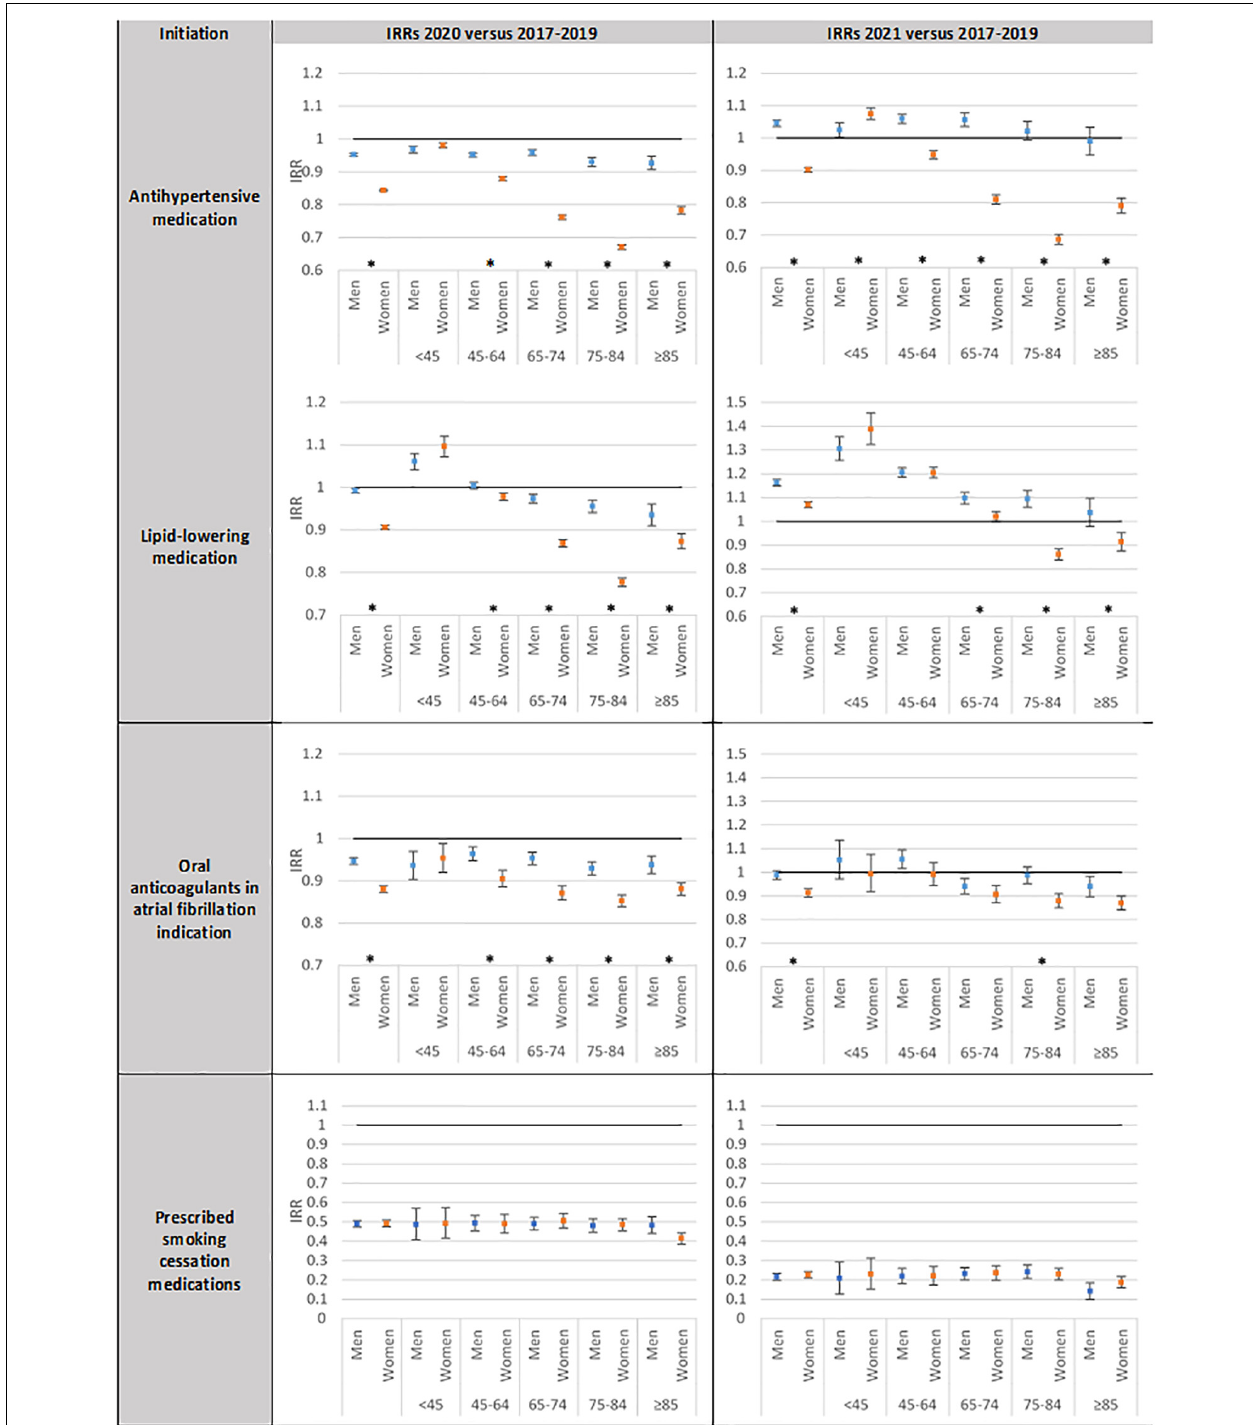
FIGURE 1 | Incidence rate ratio (IRR) a and 95% confidence intervals (95% CI) between the rates of treatment initiation, respectively in 2020 and 2021 compared to the rates of initiation in 2017–2019 according to lockdown/curfew time-periods. Gray: lockdown period; light gray: curfew period. a adjusted for age and 2017–2019 time trends; W: